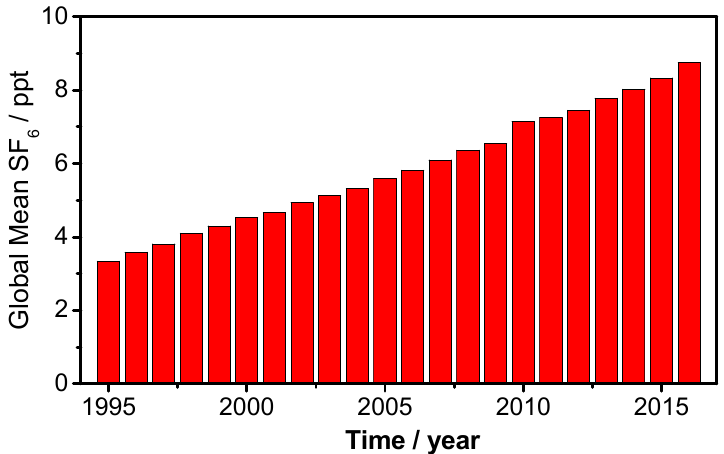
Figure 2. The concentration of SF 6 in the atmosphere since